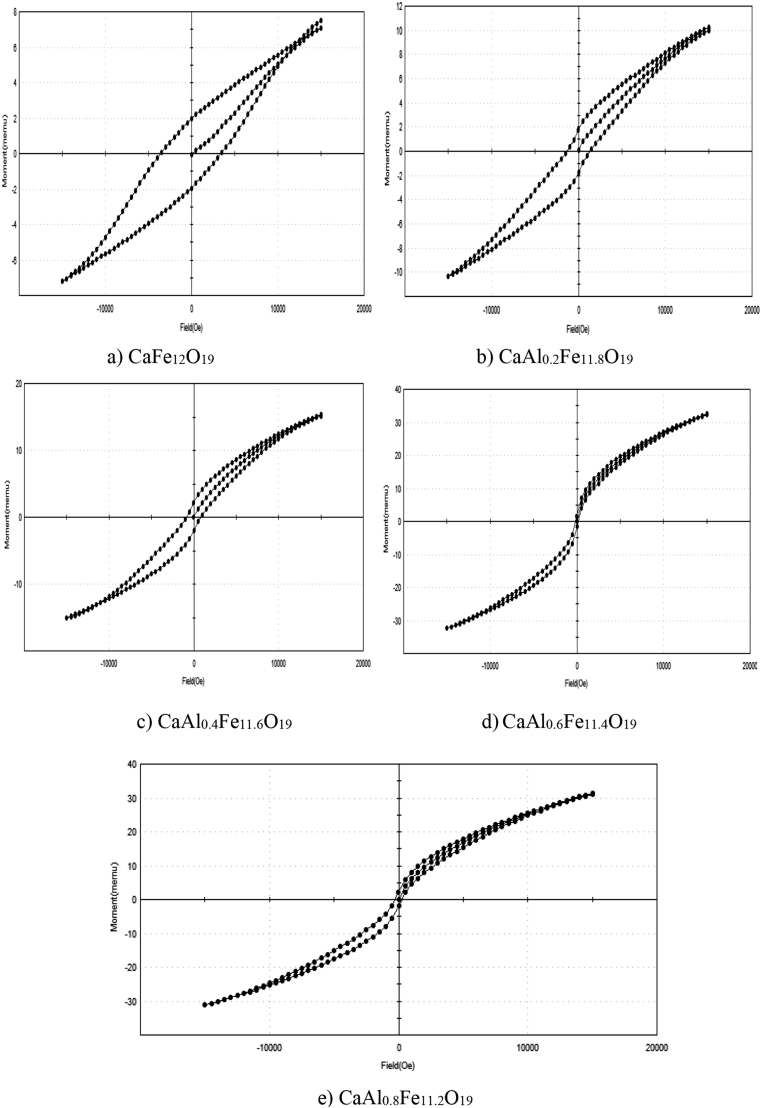
Hysteresis loop of CaAlxFe12-xO19 magnetic powder a) CaFe12O19 b)CaAl0.2Fe11.8O19 c) CaAl0.4Fe11.6O19 d) CaAl0.6Fe11.4O19 e) CaAl0.8Fe11.2O19.